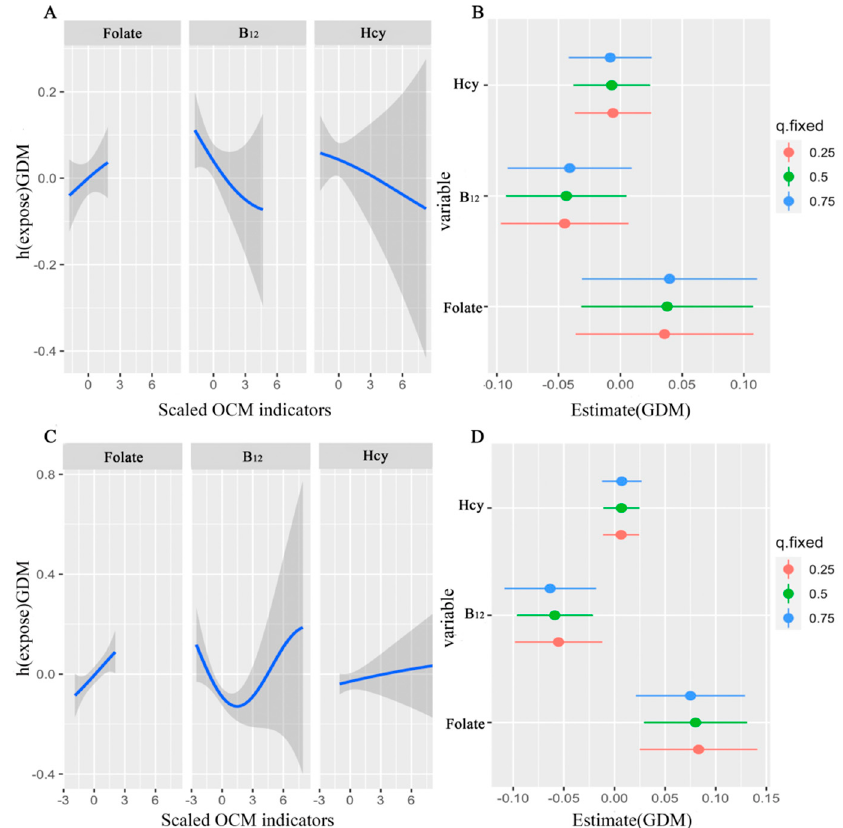
Figure 2. Joint effect of OCM indicator mixture on GDM estimated by Bayesian Kernel Machine Regression (BKMR). Model adjusted for age, ethnicity, education, drinking, smoking, parity, family history of diabetes, and prepregnancy BMI. ( A , C ) Univariate exposure-response functions and 95% confidence bands for each OCM indicator with the other two indicators fixed at their median among pregnancies with rs1801131 GG/TG and TT genotype, respectively. ( B , D ) Single nutrient association (estimates and 95% CI) between OCM indicator and GDM among pregnancies with rs1801131 GG/TG and TT genotype, respectively. This plot compares the GDM when a OCM nutrient is at the 75th vs. 25th percentile, when all the other OCM indicators are fixed at either the 25th, 50th, or 75th percentile.